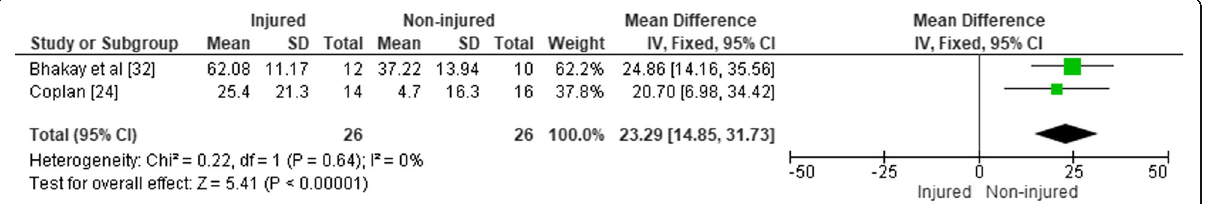
Fig. 3 Forest plot of the comparison of compensated turnout between injured and non-injured